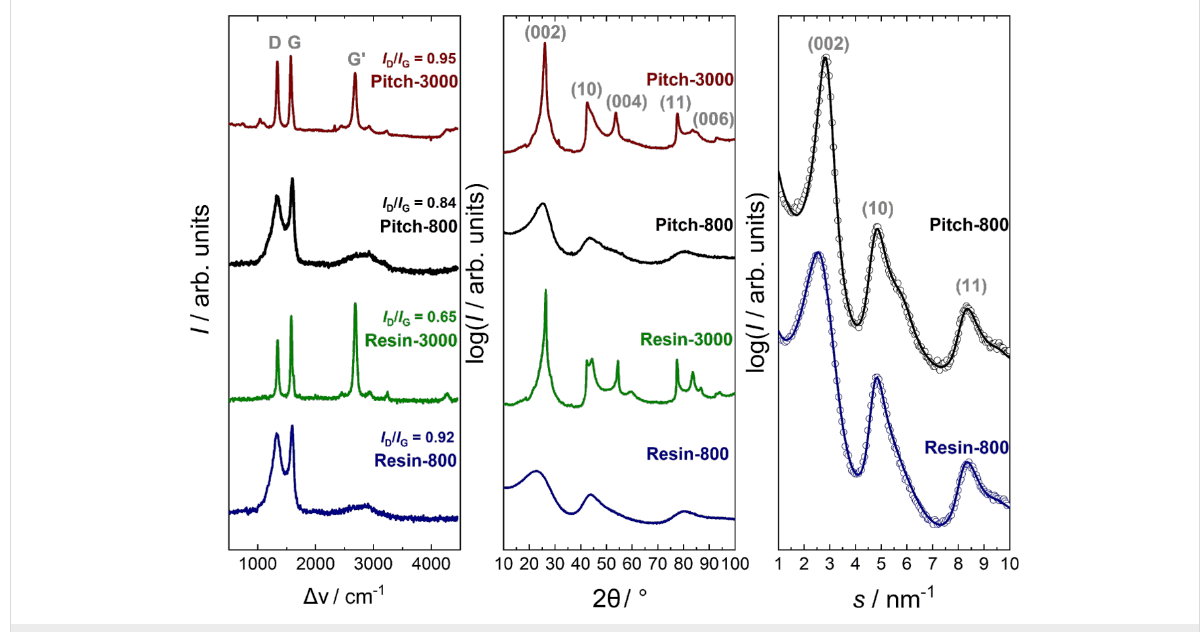
Figure 6: Raman data, WAXS data and fits (lines) of the WAXS data (open circles).